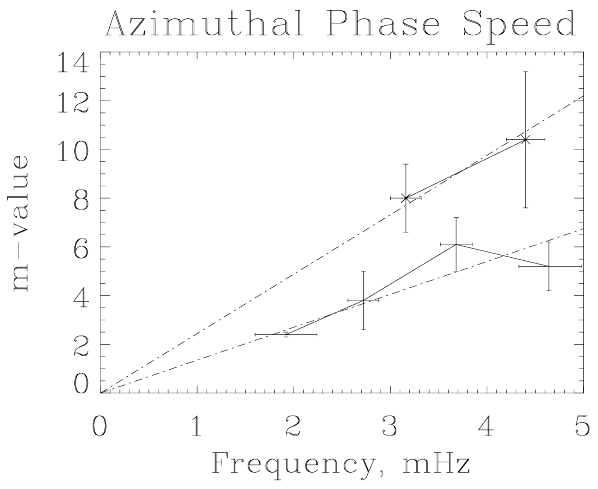
Fig. 21. Wave frequency and m -values from the two discrete fre- quencies in the wavepacket between 01:30–02:00UT ( x -symbols) and the four discrete frequencies in the wavepacket between 04:45– 06:10UT. Dot-dashed lines represent lines of approximate best fit through the origin in each case. See text for more